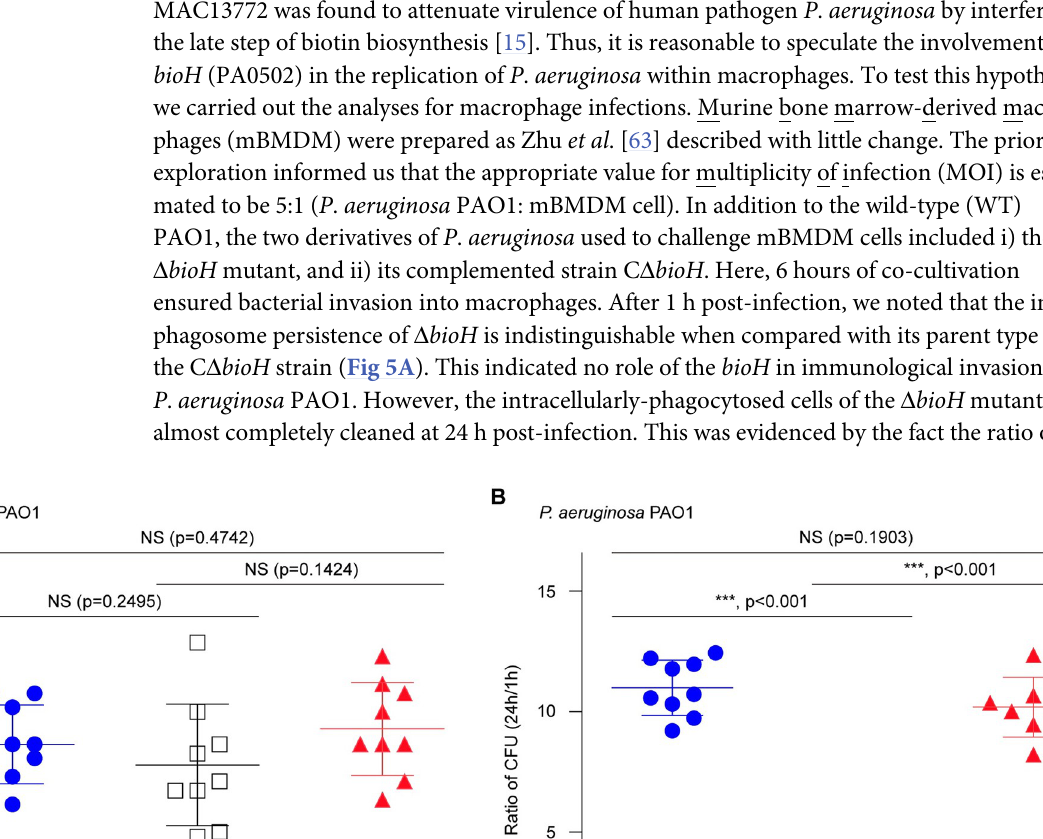
PLOS Pathogens| https://doi.org/10.1371/journal.ppat.1011110 January23,